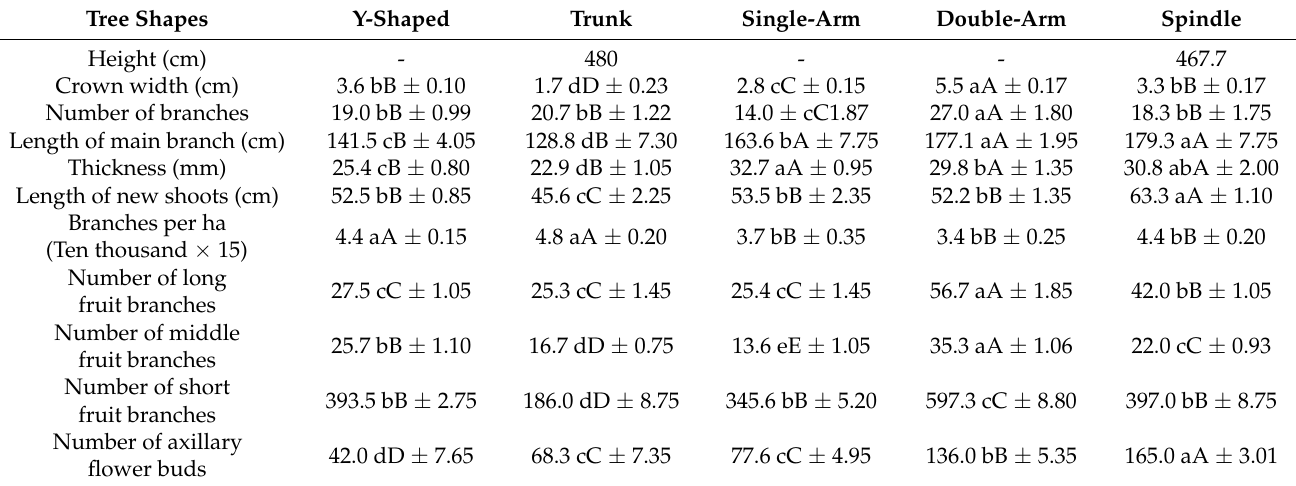
Table 1. Investigation of the tree indices of Zaosu pear trees with different